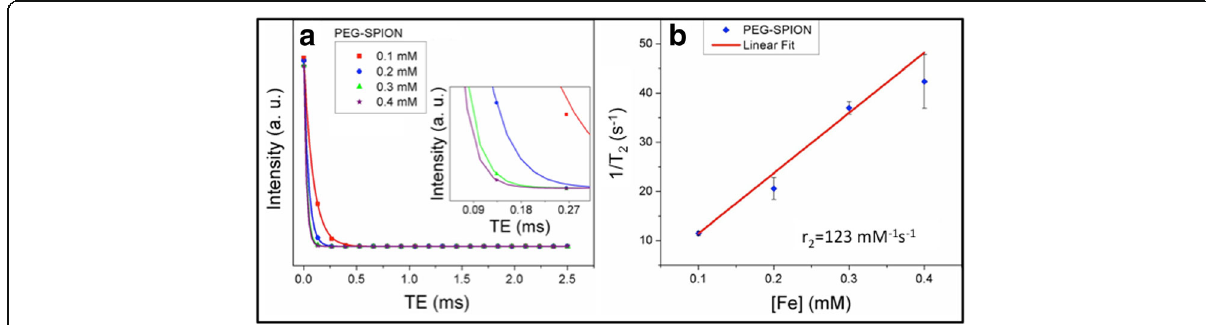
Fig. 9 a Transverse intensity vs echo time curves and b T2 relaxation rate as a function of iron concentrations for PEG-SPION at human body temperature